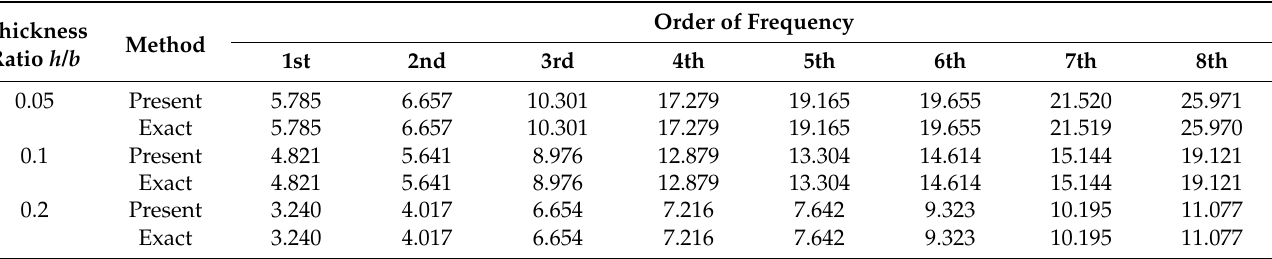
Table 8. The nondimensional frequency Ω for SSSF laminates.